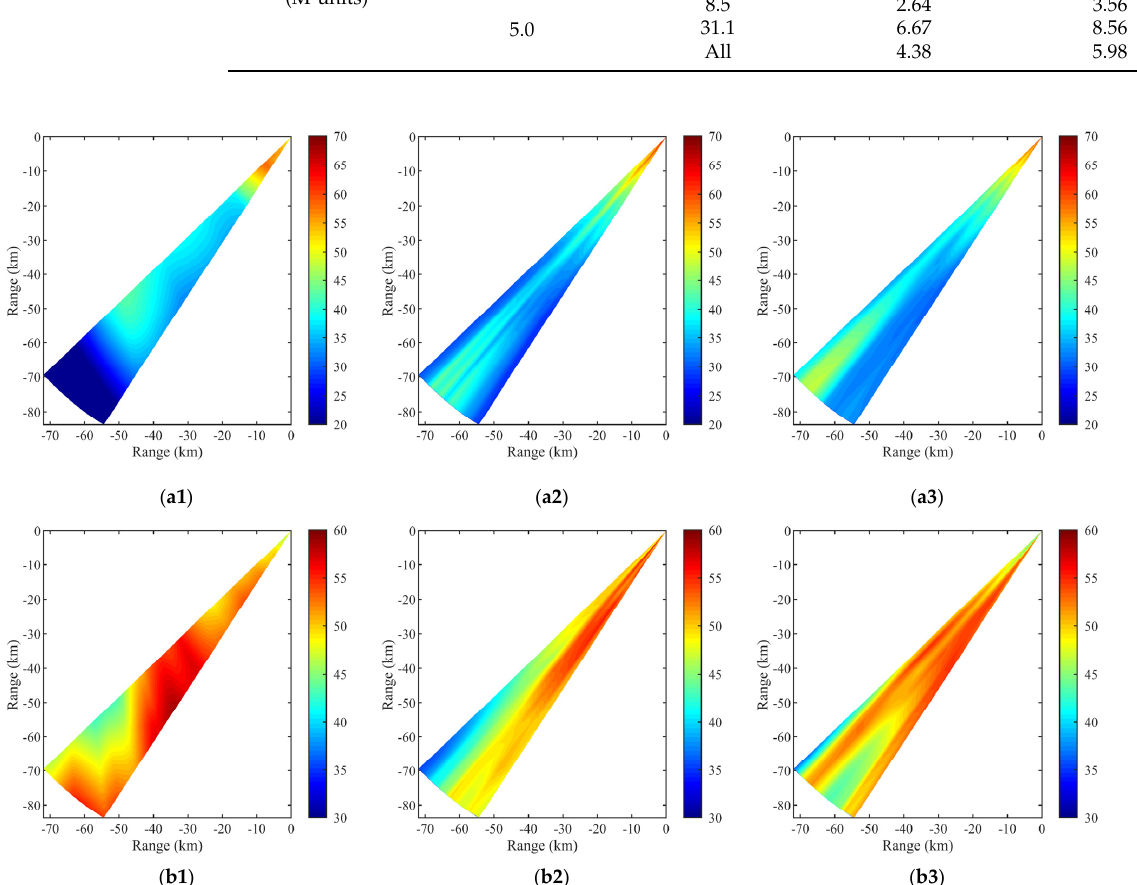
Figure 20. The regional distributions of the estimated and inverted duct parameters at different SNR cases: ( a1 ) the estimated duct height (m); ( a2 ) the inverted duct height (m) at the SNR of 15 dB; ( a3 ) the inverted duct height (m) at the SNR of 5 dB; ( b1 ) the estimated duct strength (M-units); ( b2 ) the inverted duct strength (M-units) at the SNR of 15 dB; ( b3 ) the inverted duct strength (M-units) at the SNR of 5 dB.